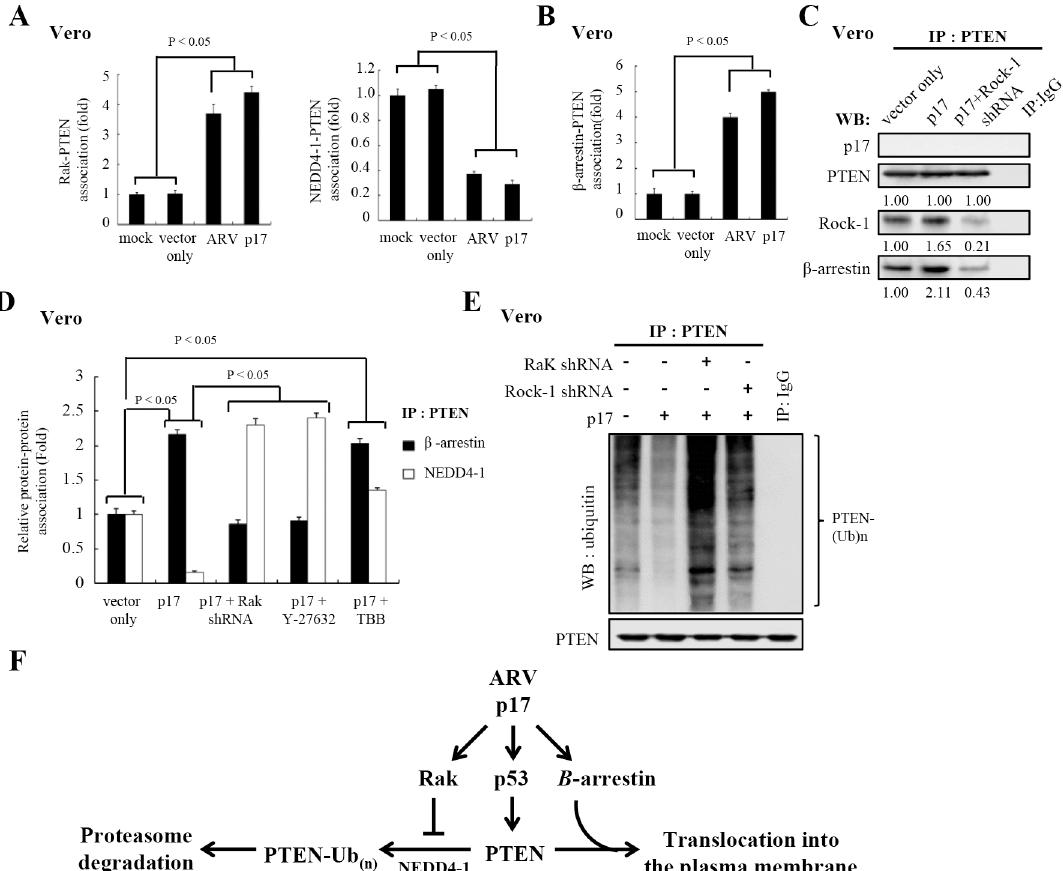
Fig 7. p17 stabilizes PTEN by promoting Rak-PTEN association and by stimulating phosphorylation of PTEN to protect PTEN from NEDD4-1 targeting. (A) In reciprocal co-immunoprecipation experiments, the amounts of Rak and PTEN association were examined in ARV-infected or p17-transfected cells. Western blot assay of PTEN, and NEDD4-1 contained in PTEN or Rak immunoprecipates was carried out. The p17-transfected, mock- transfected, mock-infected, and ARV-infected cells were collected at either 24 hpi or 24 hours post-transfection for Western blot assays. Data shown represent the mean ± SD calculated from three independent experiments. The amounts of Rak-PTEN and NEDD4-1-PTEN associations were normalized against those at mock-transfection and mock-infection. The level of mock controls was considered 1-fold. (B) In reciprocal co-immunoprecipation experiments, the binding of β -arrestin to PTEN was examined in either ARV-infected or p17-transfected Vero cells. Western blot of β -arrestin, PTEN, and NEDD4-1 contained in PTEN or β -arrestin immunoprecipates was carried out. Data shown represent the mean ± SD calculated from three independent experiments. The amounts of β -arrestin-PTEN associations were normalized against those at mock-transfection and mock-infection. The level of mock controls was considered 1-fold. (C) In coimmunoprecipation experiments, the binding of β -arrestin to PTEN was examined in p17-transfected Vero cells. Western blot of PTEN and β -arrestin contained in PTEN immunoprecipates was carried out in presence and absence of Rock-1 shRNA. Rabbit IgG was used as a negative control. The representative data are from three independent experiments. The activation and inactivation folds indicated below each lane were normalized against those at vector only. The level of indicated proteins at vector only was considered 1-fold. (D) The interaction between PTEN and β - arrestin as well as between NEDD4-1 and PTEN were examined in p17-transfected and mock-transfected Vero cells. Proteins immunoprecipated with an anti-PTEN antibody from Vero cell lysates treated with Rak shRNA, Y-27632, and TBB, respectively were resolved by SDS-PAGE and immunbloted with the indicated antibodies. Data shown represent the mean ± SD calculated from three independent experiments. (E) Cells were co-transfected with pcDNA3.1-p17 plasmid with either Rak or Rock-1 shRNA for 24 hours. The cells were harvested and washed twice in PBS buffer and scraped in 200 μ l of lysis buffer. About 500 ug of cellular proteins was incubated with 4 ug of anti-PTEN antibody at 4°C overnight. The immunoprecipitated proteins were separated by SDS-PAGE followed by Western blot assay, and then proteins were detected with anti-ubiquitin antibody. Rabbit IgG was used as a negative control. The representative data are from three independent experiments. (F) A model illustrates the PTEN regulation by